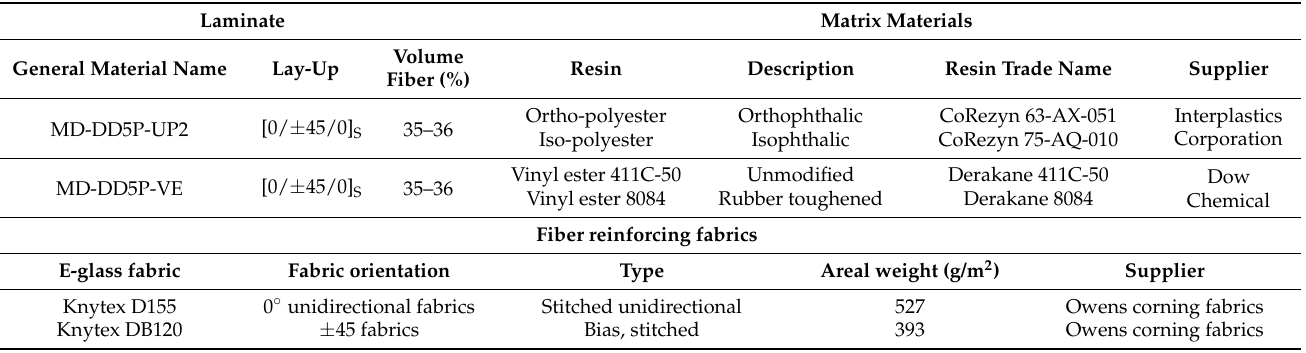
Table 1. Different resins investigated.